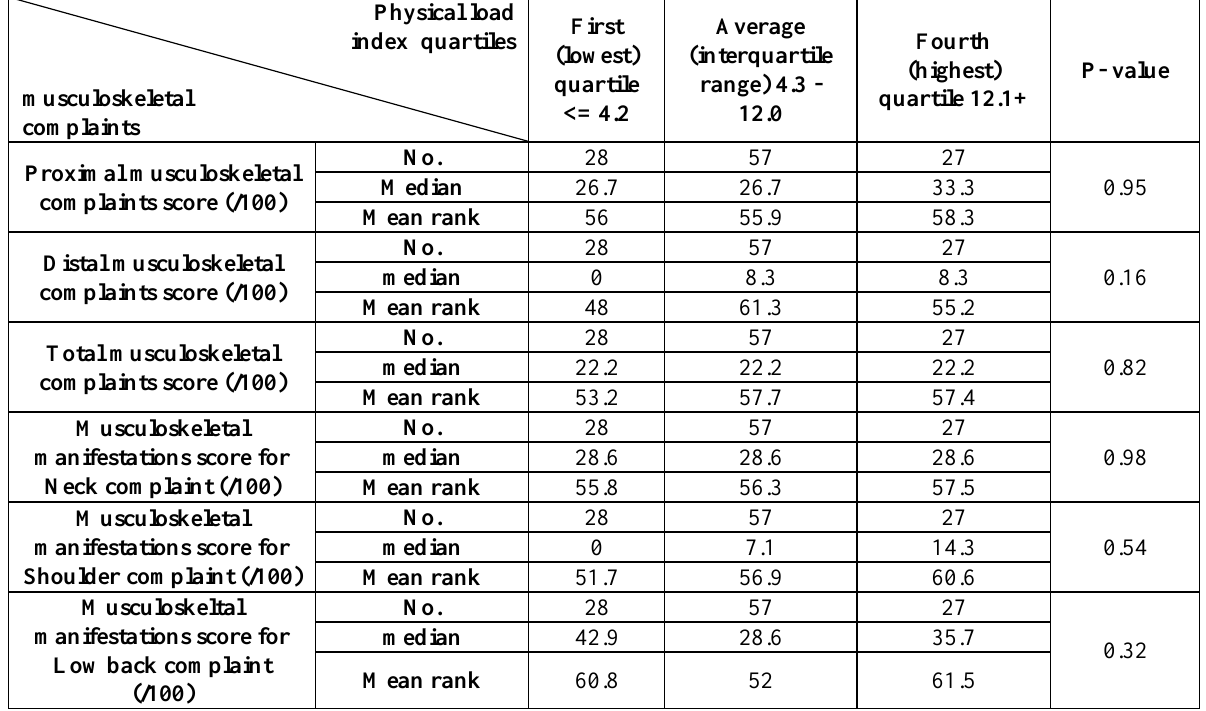
Table 4: Musculoskeletal complaints according to physical work load index quartiles.